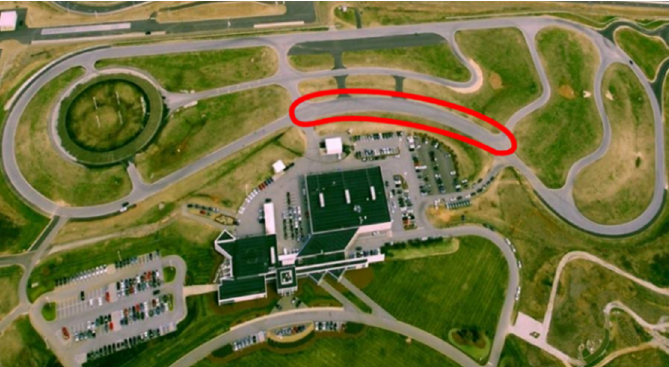
Figure 1. Aerial view of the closed-road course (ABS exercise area in red).